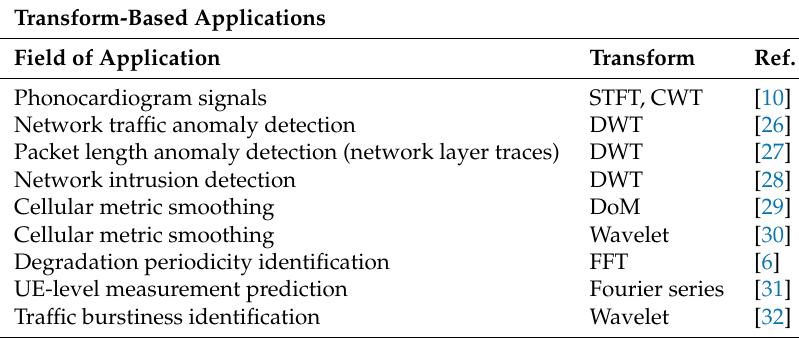
Table 2. Summary of related works on transform-based analysis. DoM, Difference over